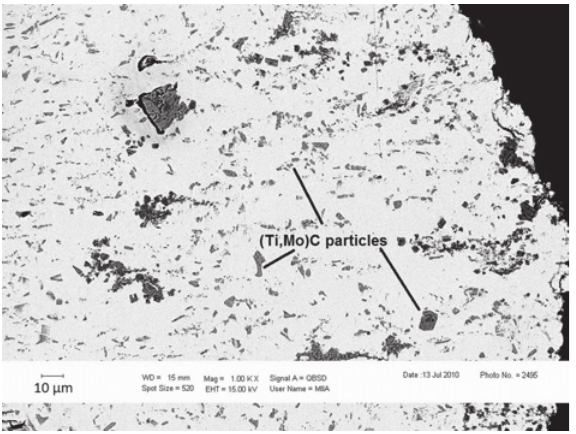
Fig. 13: SEM-BSE image of TiC and (Ti,Mo)C particles in experiment